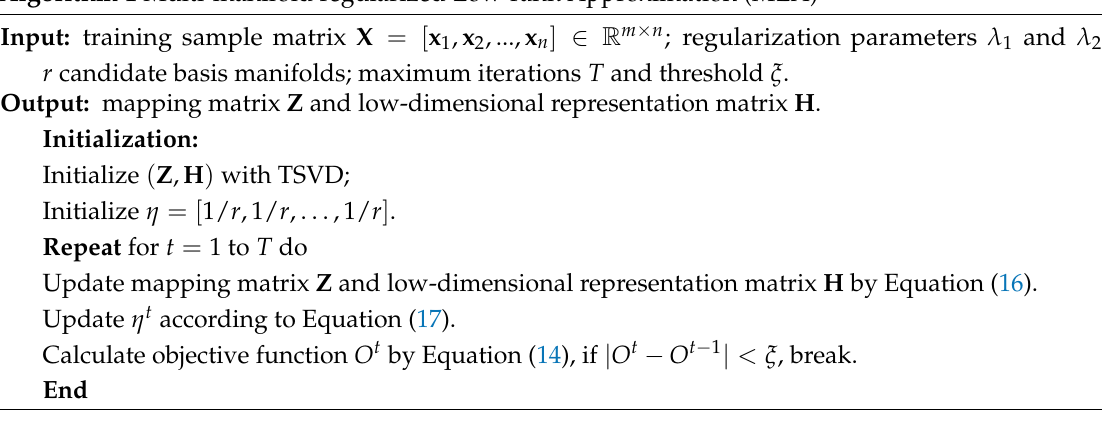
Algorithm 1 Multi-manifold regularized Low-rank Approximation